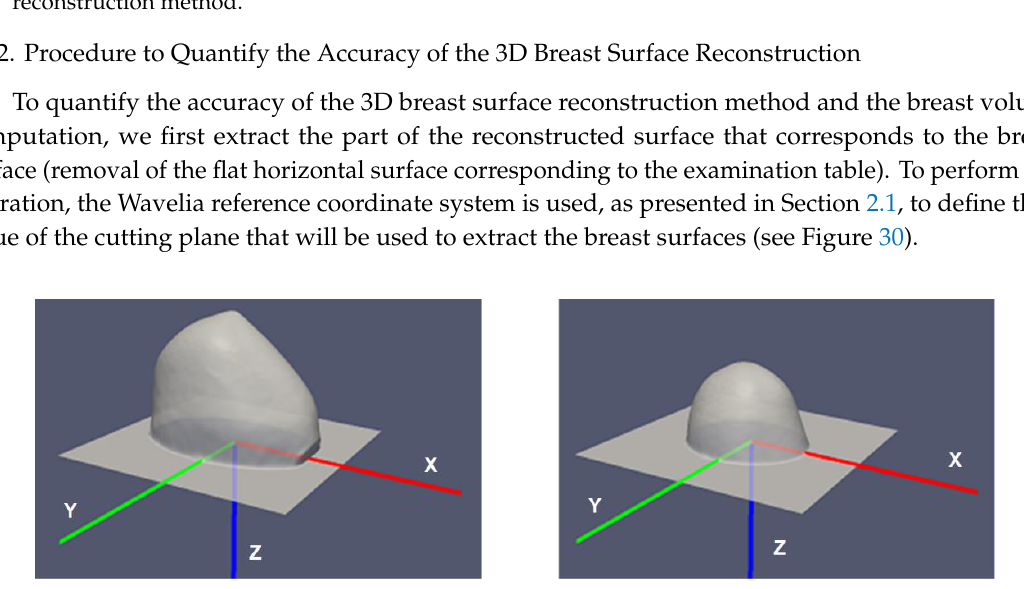
Figure 30. Wavelia reference coordinate system and 3D reconstructions of the breast phantoms B1 and B2.